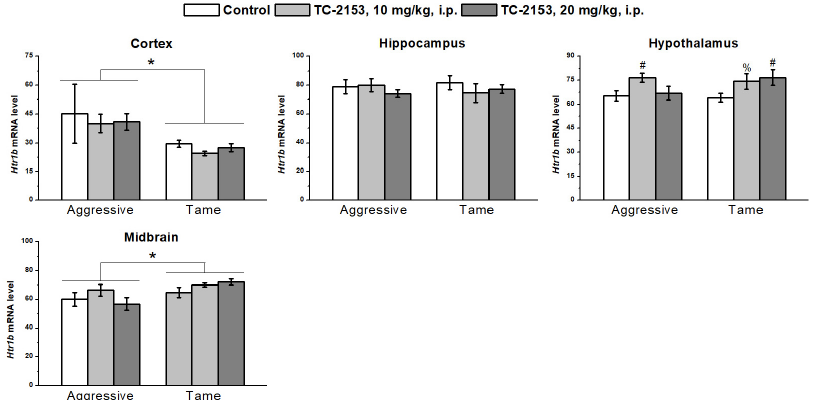
Figure 7. The influence of acute administration of vehicle (control) or TC-2153 at a dose of 10 or 20 mg/kg on 5-HT 1B receptor ( Htr1b ) mRNA levels in the cortex, hippocampus, hypothalamus, and midbrain of aggressive and tame rats. The expression levels were evaluated as the number of transcript copies per 100 copies of Polr2a mRNA. * p < 0.05 for the genotype effect; # p < 0.05 and % p = 0.062 in comparison with the control group (5–7 animals per group).